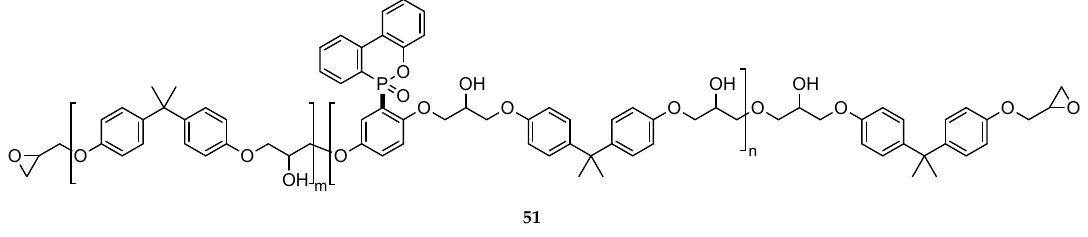
Figure 23. DOPO-BQ ( 48a ) functionalized DGEBA resin 51 .